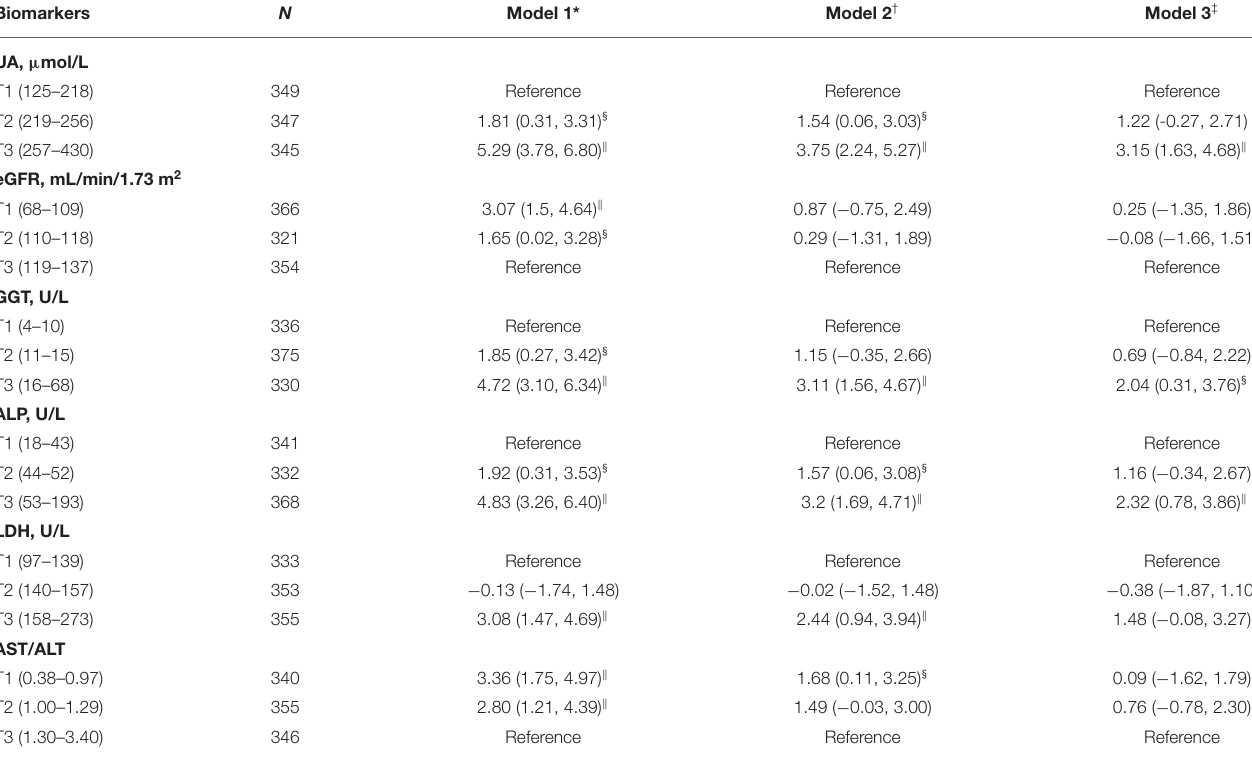
TABLE 2 | Longitudinal associations of early-pregnancy biomarkers levels with systolic blood pressure levels during pregnancy.